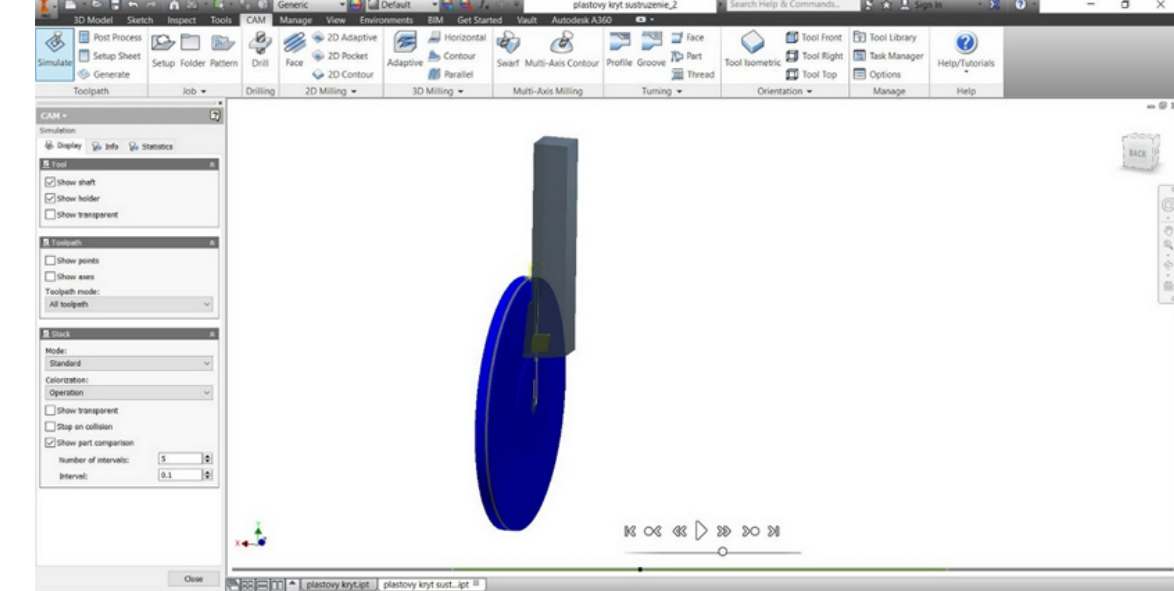
Figure 5: Simulation of the face processing of the semi-finished piece.